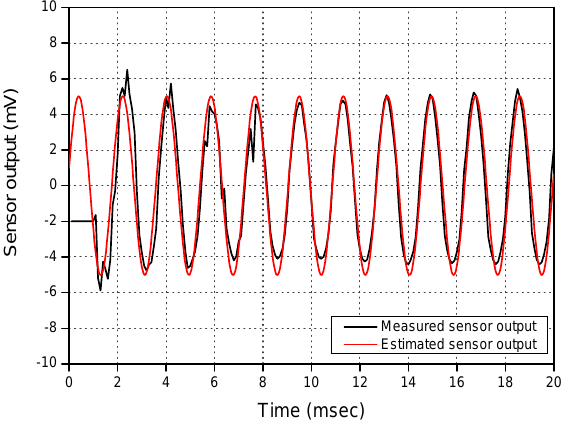
Figure 17. Recorded and estimated sensor output signals in firing